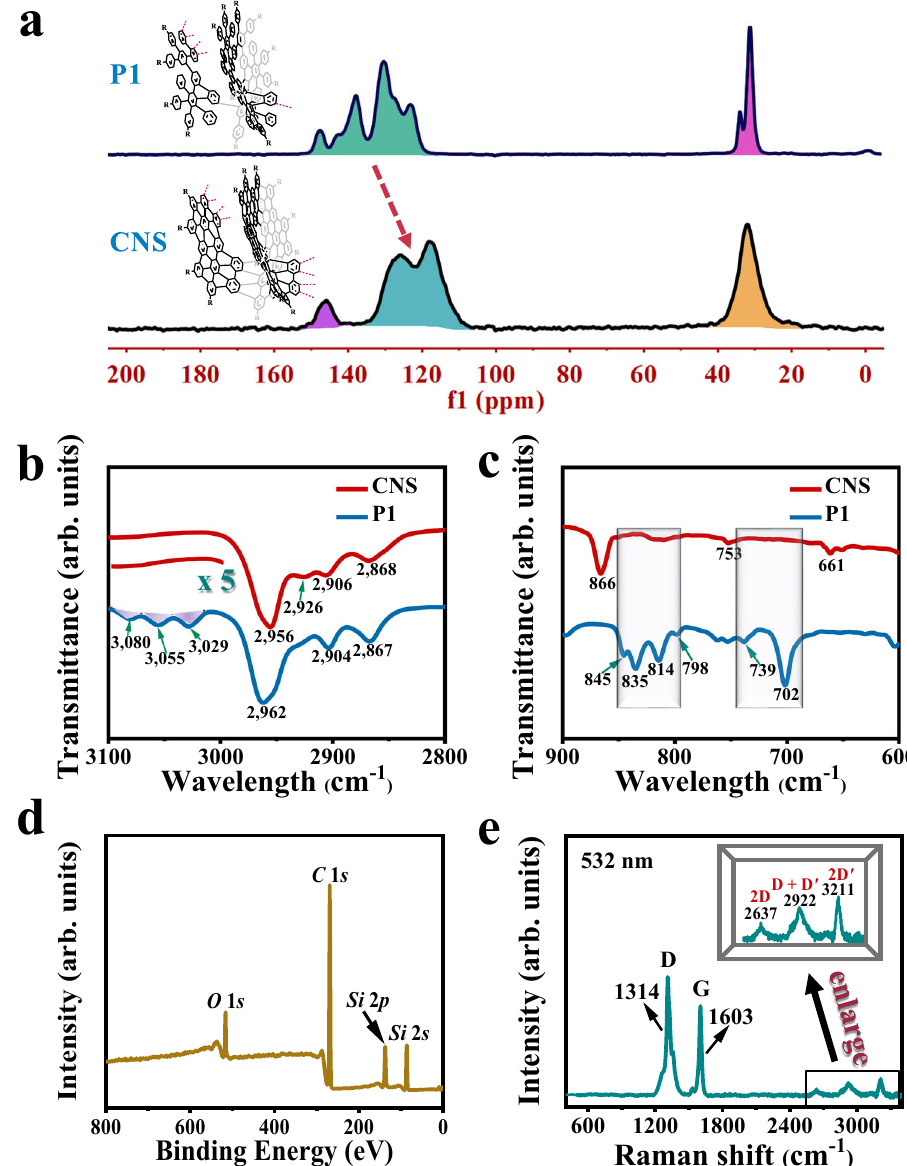
Fig. 3 Structural characterizations of CNS. a Solid-state 13 C NMR spectra of P1 and CNS. b, c Representative FT-IR spectra regions of polyphenylene precursor P1 (blue lines) and CNS (red lines) show the disappearance of the bands derived from mono- and disubstituted benzene rings after graphitization. d XPS spectrum of CNS. e Raman spectrum of CNS measured at 532nm (2.33eV) on a powder sample with laser power below 0.1mW. The inset shows a magni fi ed area of the spectrum (bottom right) to display peaks of 2D, D + D ′ , and 2D ′